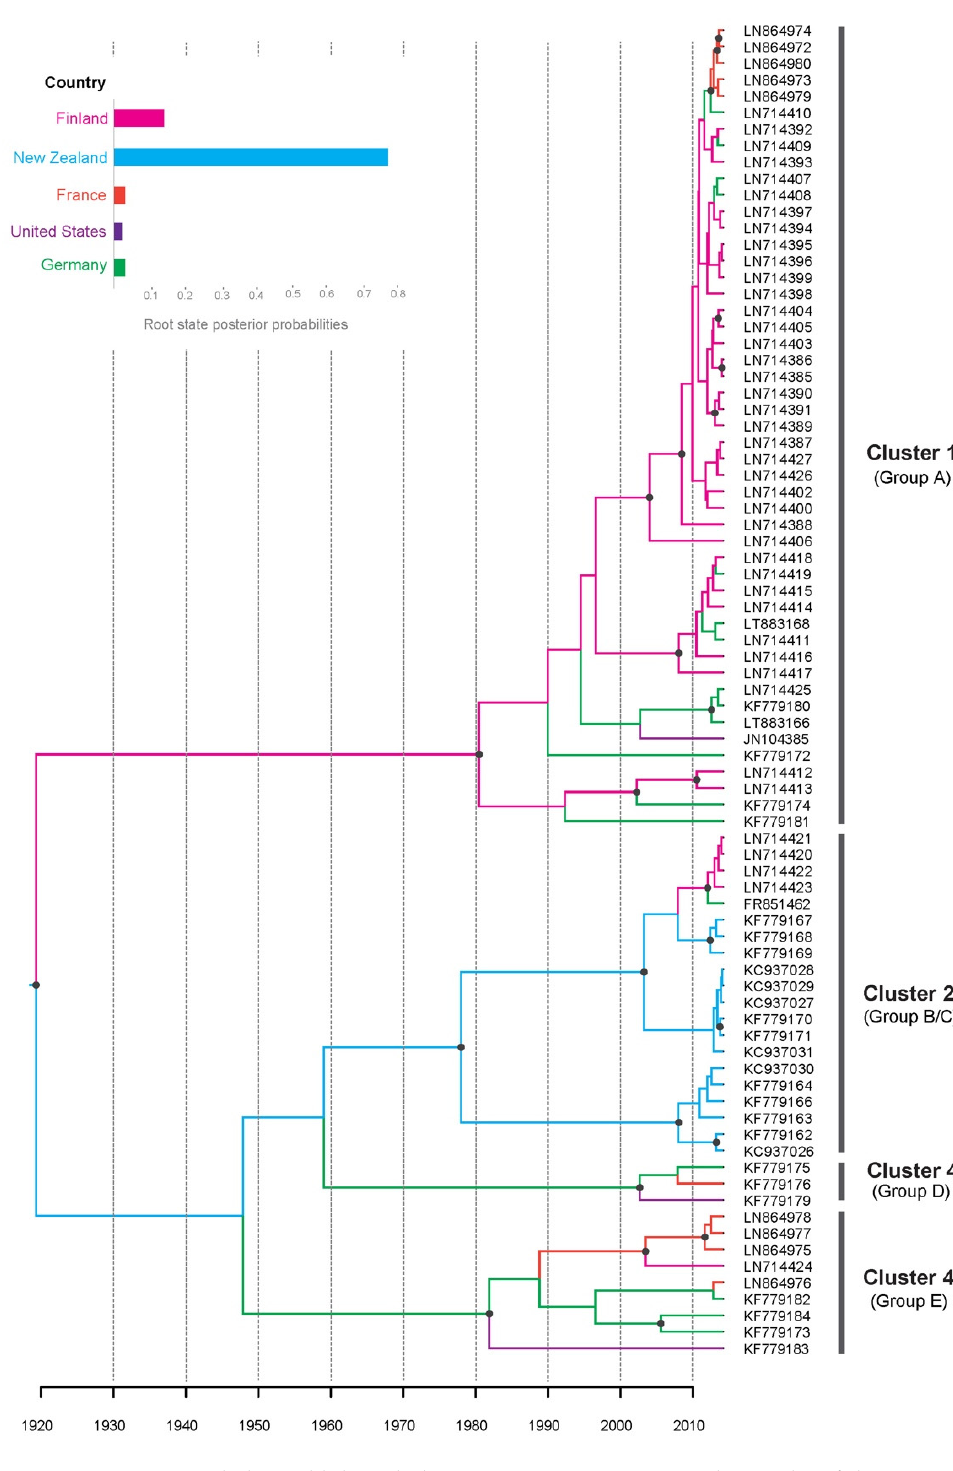
Figure 1. Maximum clade credibility phylogenetic tree summarizing the results of the Bayesian inference. Branch colors indicate inferred region states, as shown in the color key. Only the posterior probabilities (>0.95) are indicated by a black dot on each node. The time axis is scaled to the branch length in units of year. Parentheses below each lineage indicate phylogenetic groups A–E proposed by Rebenstorf et al. (2006).